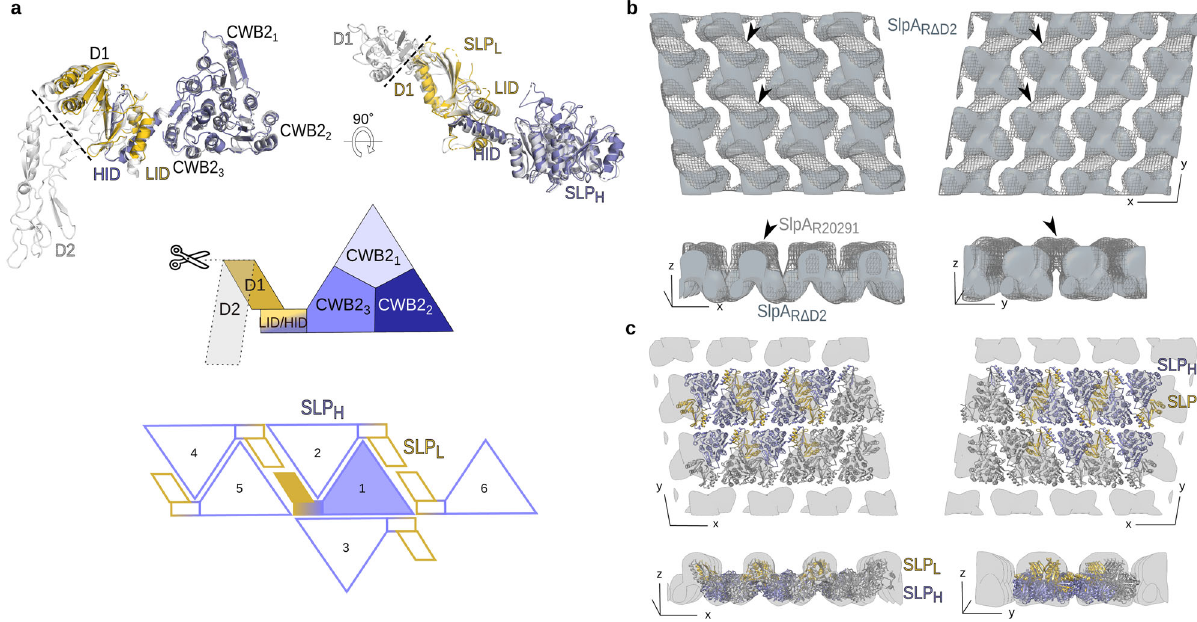
Fig. 4 The fl exible D2 domain is dispensable for S-layer assembly. a Cartoon representation of the SlpA R Δ D2 H/L complex crystal structure (slate blue and gold, PDB ID: 7ACZ), superimposed onto SlpA CD630 H/L complex structure (PDB ID: 7ACY, grey). Deleted D2 region is marked with a dashed line on the CD630 structure and corresponding schematic representation of the complex. Views as in Fig. 1b. 2D schematic of H/L complex crystal packing in SlpA R Δ D2 , indicating the interaction network linking a single H/L (slate blue/gold) complex with fi ve other molecules in a planar arrangement generated by SLP H tiling. b Superimposition of the 3D reconstruction of negatively stained S-layer ghost containing SlpA devoid of domain D2 (SlpA R Δ D2 , light blue solid surface) on the reconstruction of native wild-type S-layer ghost (SlpA R20291 , grey mesh). The missing density can be largely ascribed to that of the missing D2 domain (indicated with black arrowheads). Views as in Fig. 2d. c Fit of the SlpA R Δ D2 structure determined by X-ray crystallography (coloured as in c ) into the S-layer (grey) reconstruction indicates a similar arrangement in the crystal packing and the native array. Views as in b